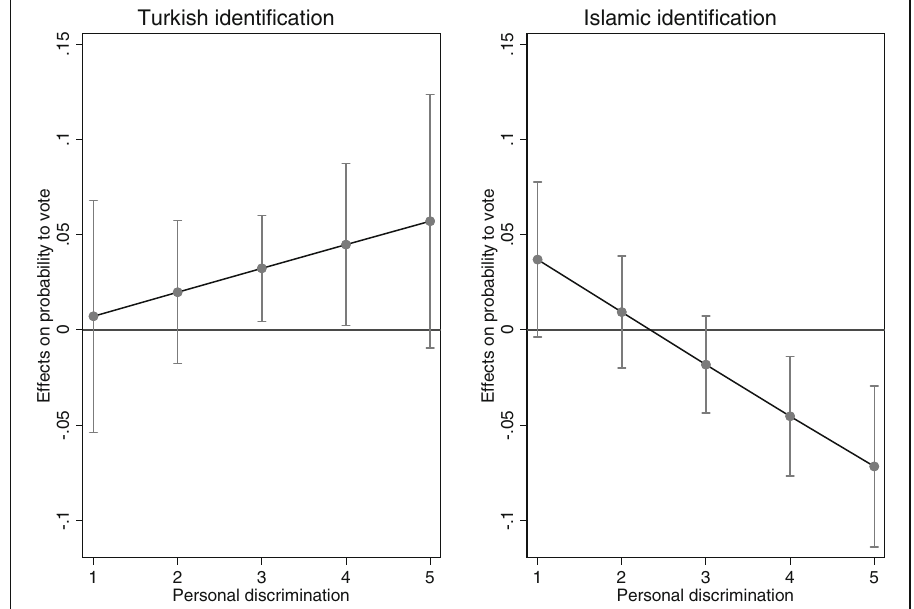
Fig. 4 Effects of Turkish and Islamic identifications on local voting according to perceptions of personal discrimination (TIES surveys 2007/2008). These graphs show the marginal effects of Turkish and Islamic identification on the probability to vote locally (vertical axis) for different levels of perceived personal discrimination (horizontal axis)